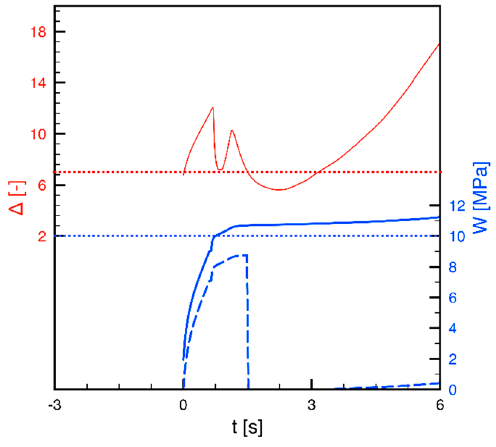
Figure 4. Predicted evolution of the molecular stretch (solid red line) and mechanical work (solid blue line) at 0.44 mm from the cavity surface for the test 80-07. The dashed blue line represents the effective mechanical work, W e .